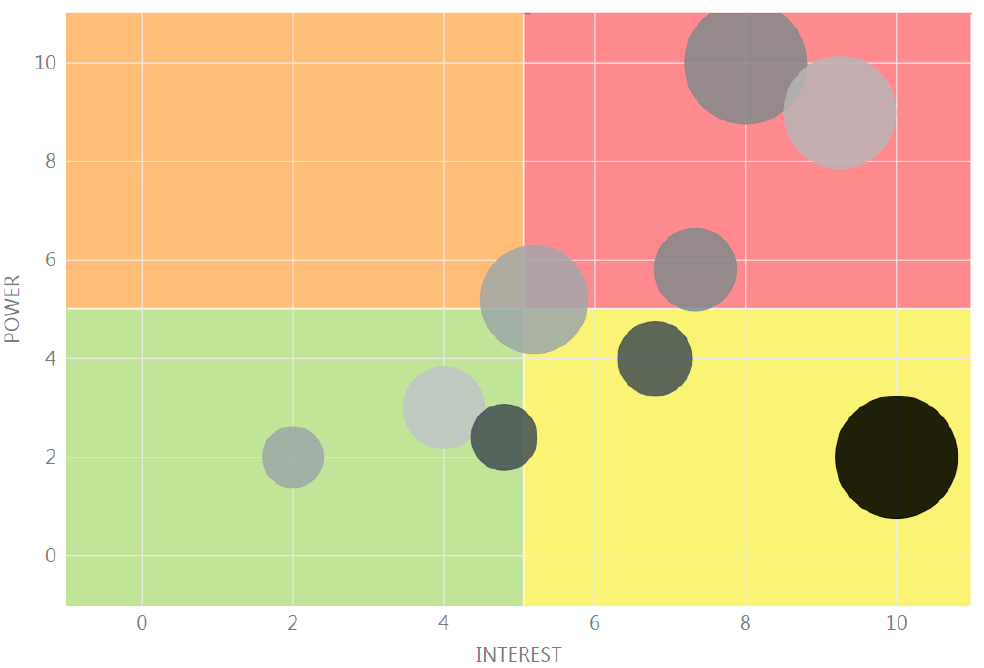
Figure 7. Example of matrix of influences between 5 stakeholders (A, B, C, D and E). A and B influence each other, B influences C, D and E influence B and C respectively. Dark grey cells do not apply (A does not influence A) and light grey cells would be repeating the relationship in white cells (example AB = BA).